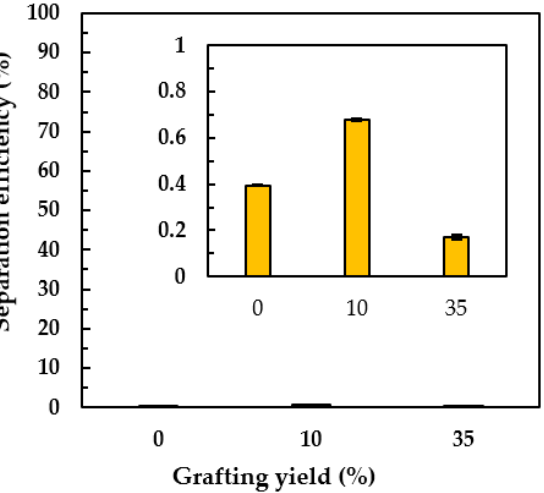
Figure 11. The separation efficiencies of the oil-water mixture at 45 ◦ C of linear PNIPAm-grafted nylon membrane with different grafting yields. The inset was the enlargement of the same graph to demonstrate the small but different separation efficiency of the membranes with different grafting yield.